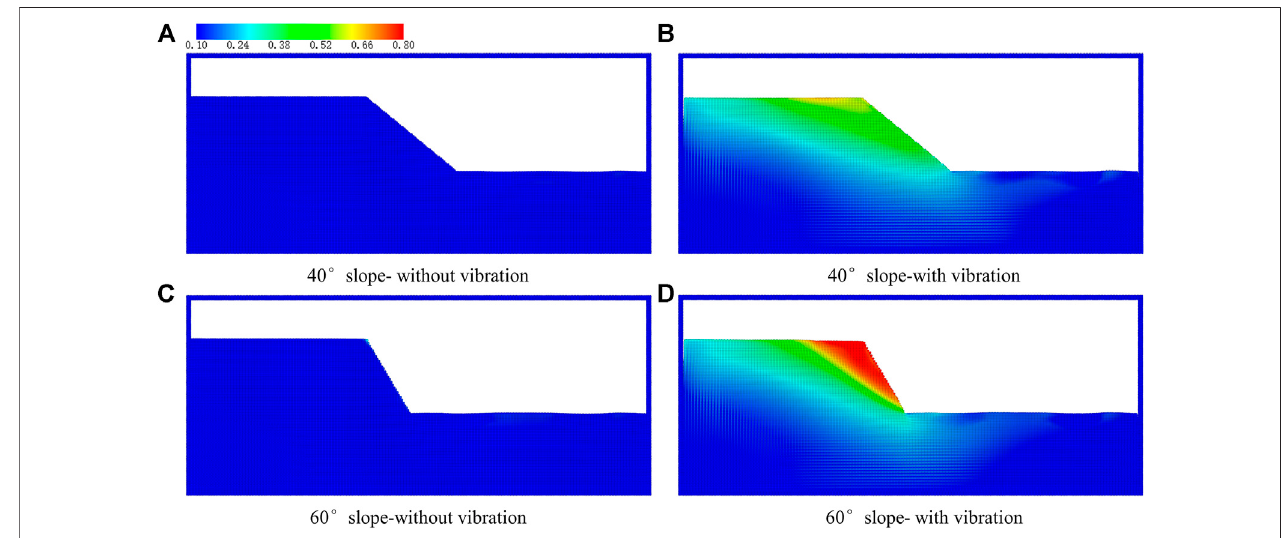
FIGURE 6 | Horizontal deformation diagram of 40 ° and 60 ° slopes with or without vibration (unit: m).